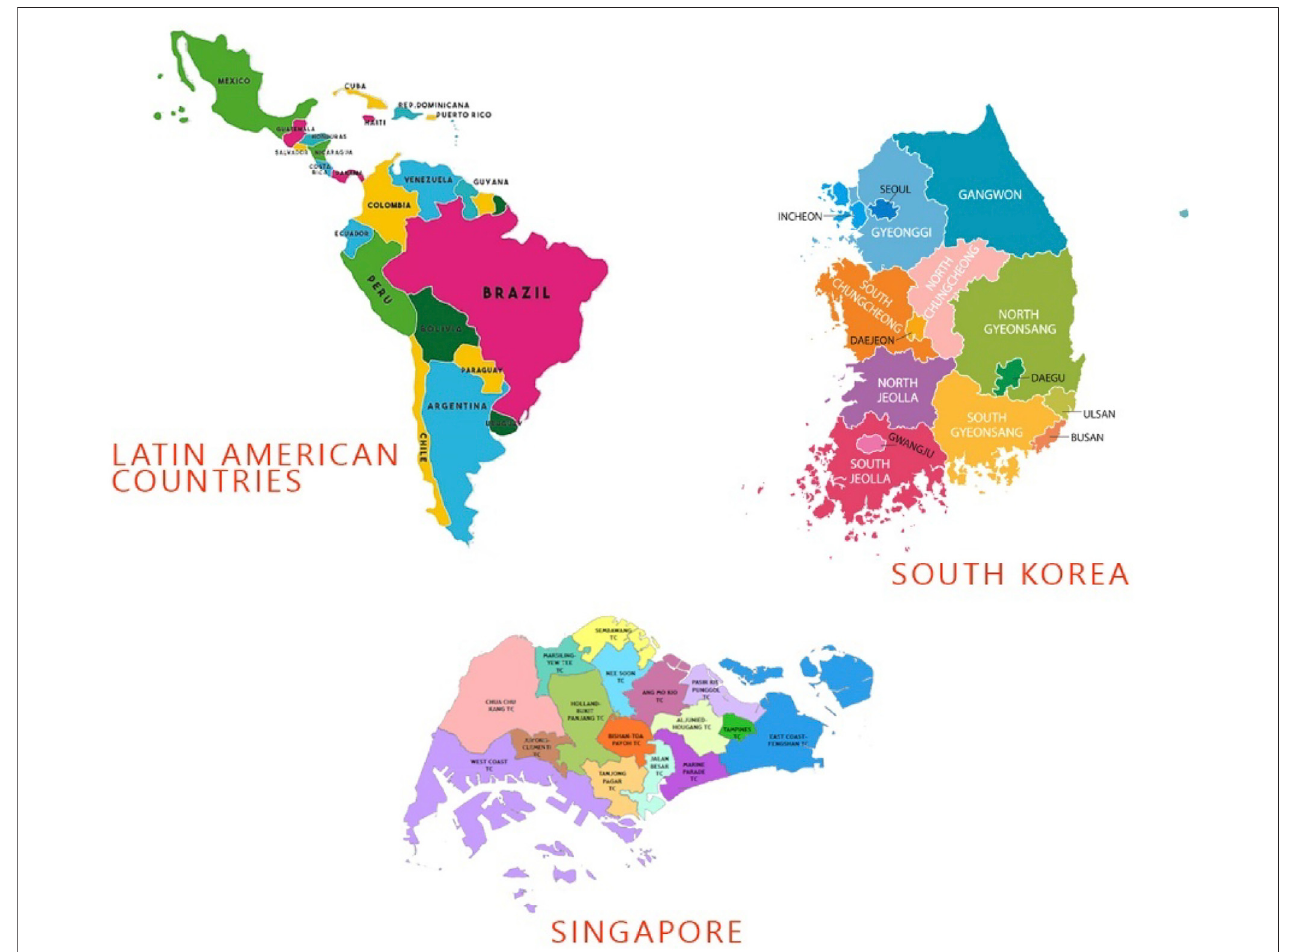
FIGURE 3 | Study area with selected countries ’ geographical